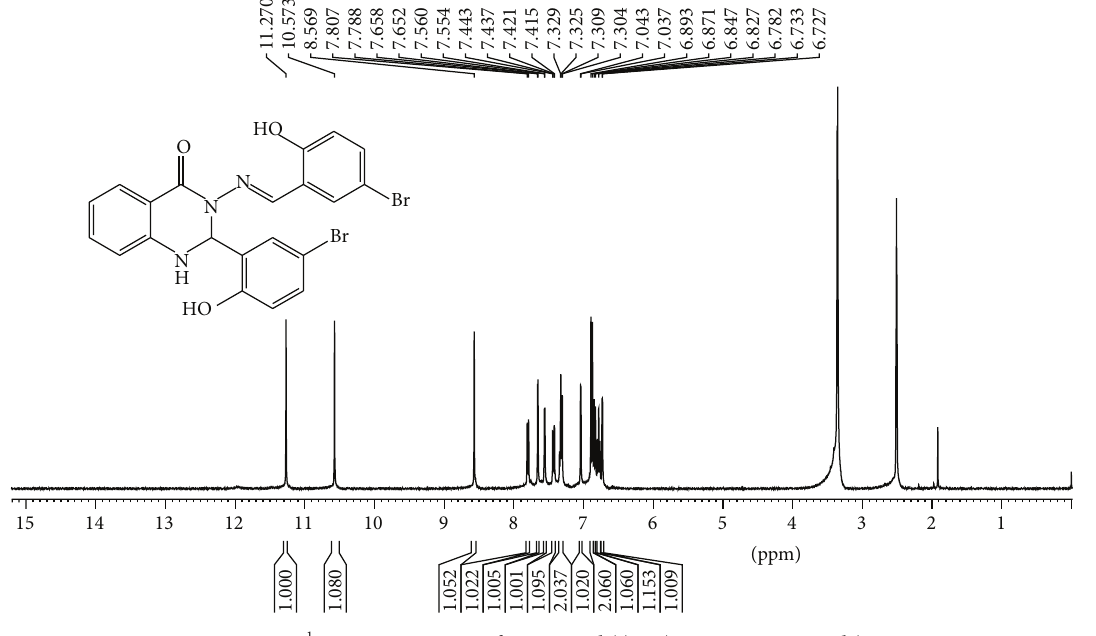
Figure 5: 1 H NMR spectrum of compound (1) in (400 MHz, DMSO- d6 ).